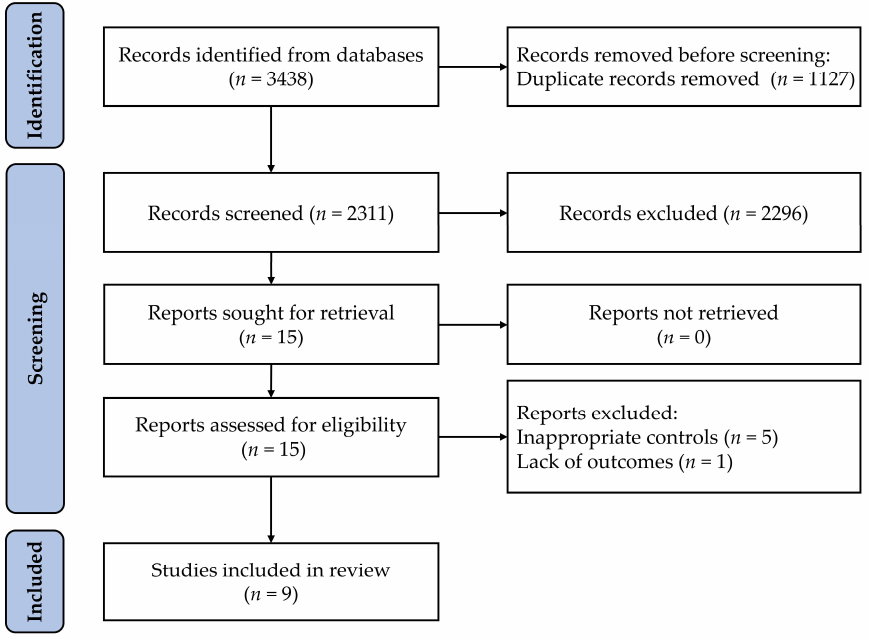
Table 2. The characteristics of the included studies.